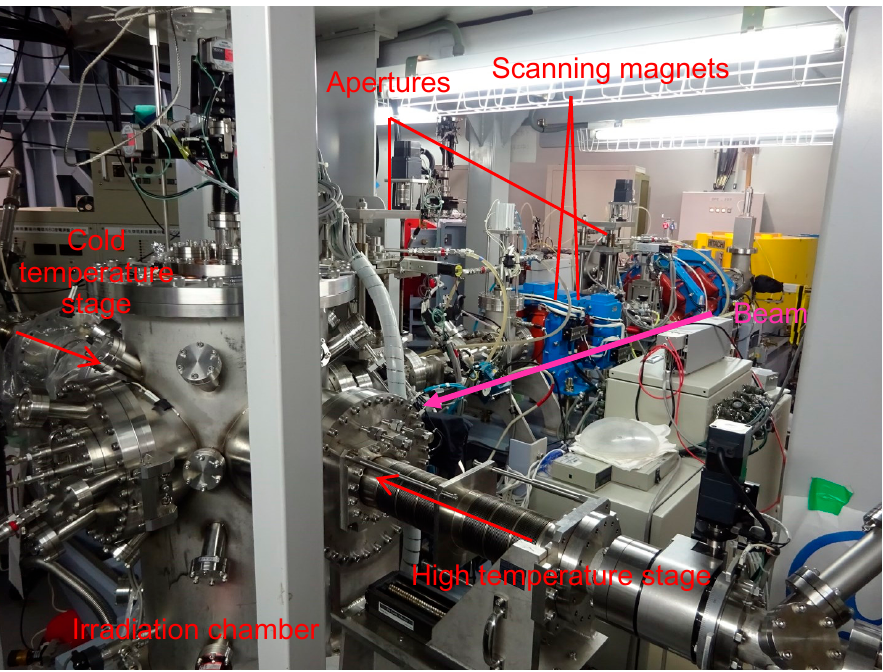
Figure 6. Beamline and irradiation chamber for the irradiation of space electronics in irradiation room 2.